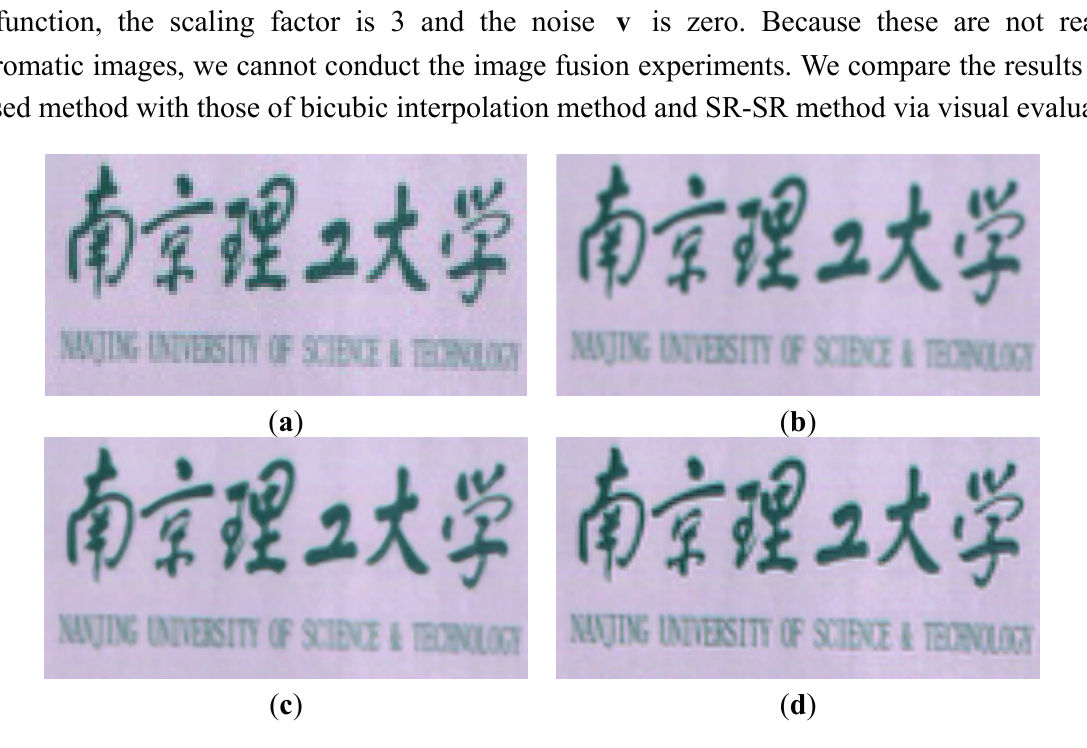
Figure 7. Experimental results of Letter paper HSI dataset (color composite of R: 31, G: 20, B: 8). ( a ) original LR HSI; ( b ) bicubic interpolation method; ( c ) SR-SR method; ( d ) the proposed